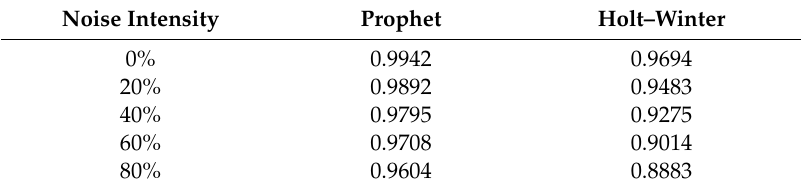
Table 2. The accuracy reduction of different models under various noise intensities.